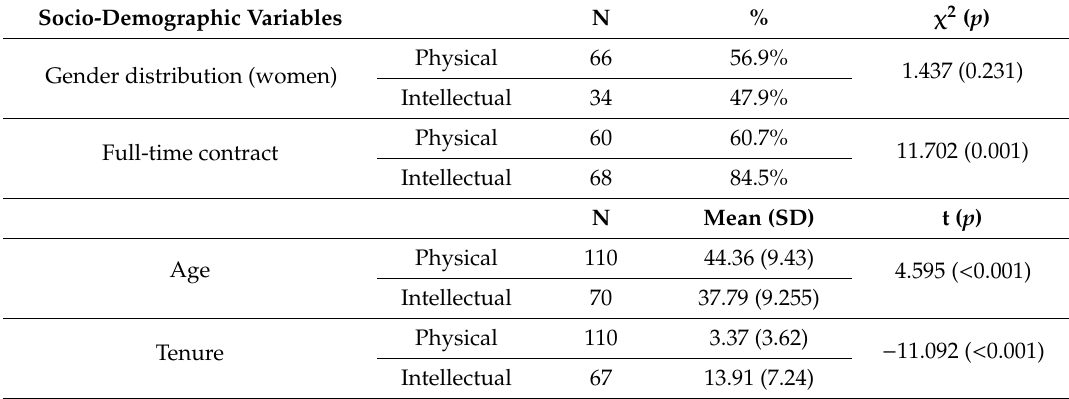
Table 1. Sample description (by groups).